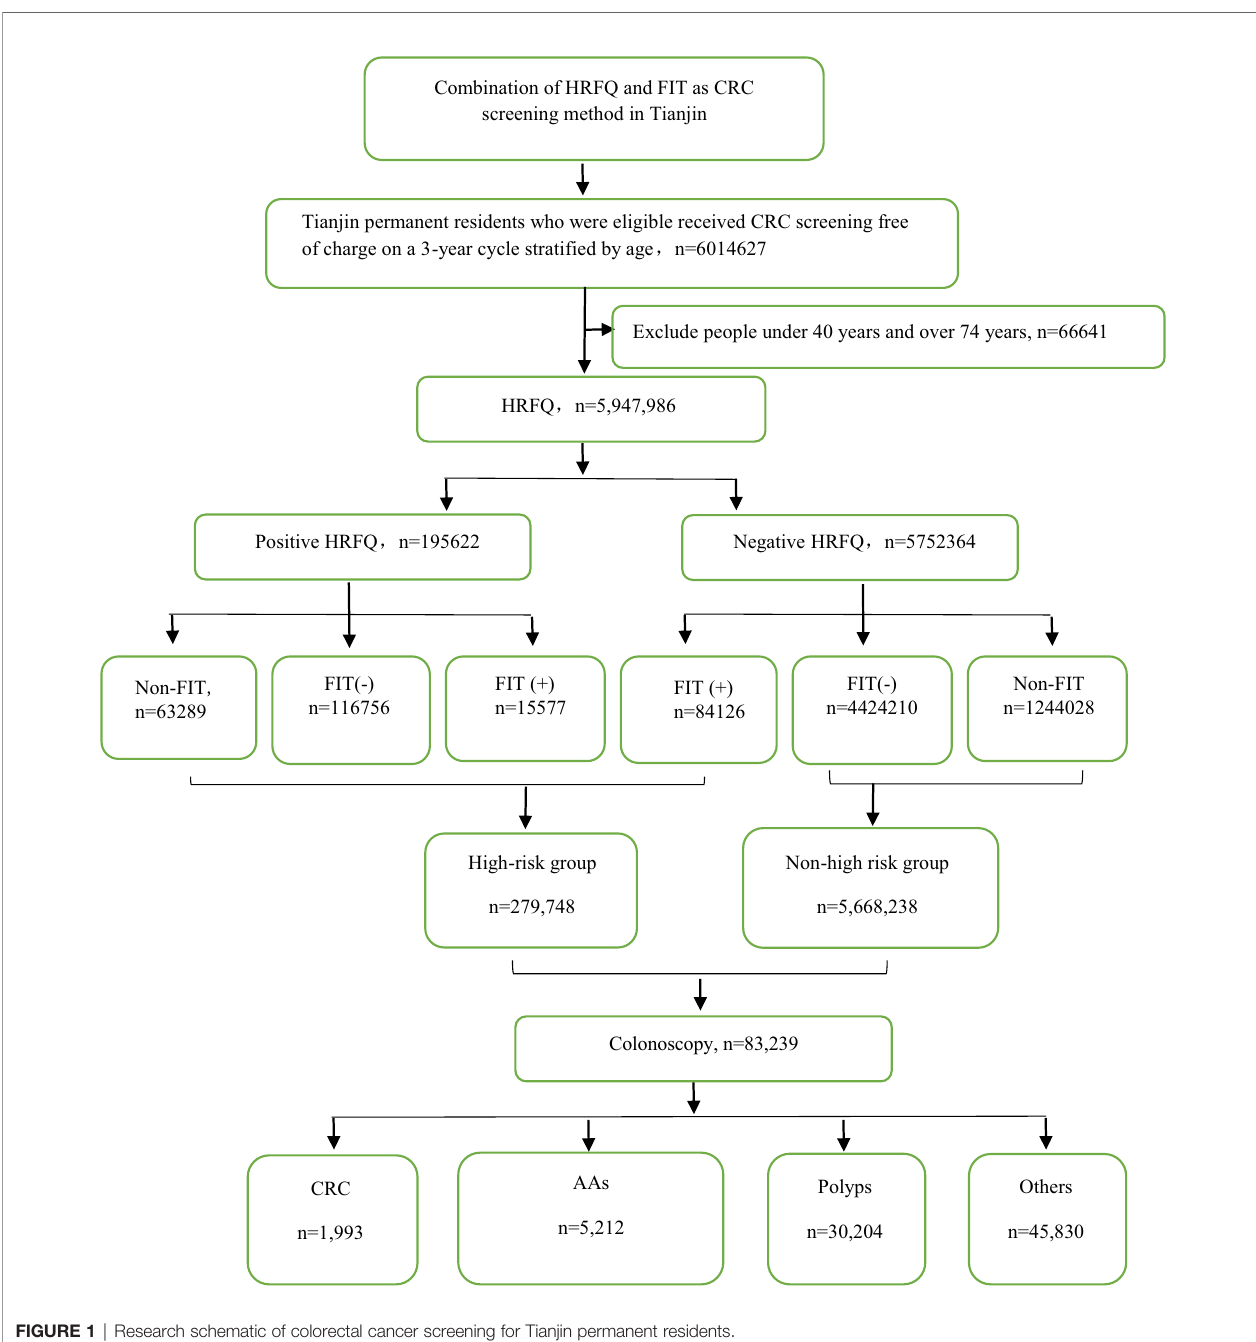
FIGURE 1 | Research schematic of colorectal cancer screening for Tianjin permanent